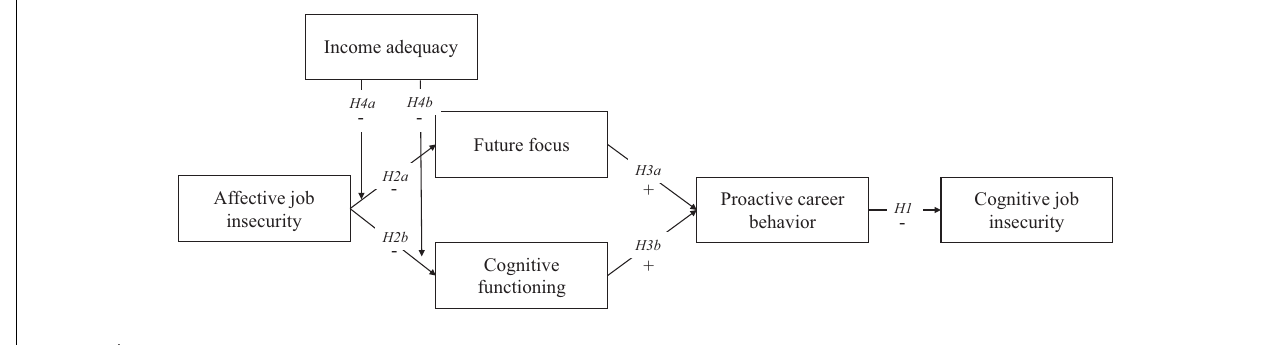
FIGURE 1 | Hypothesized